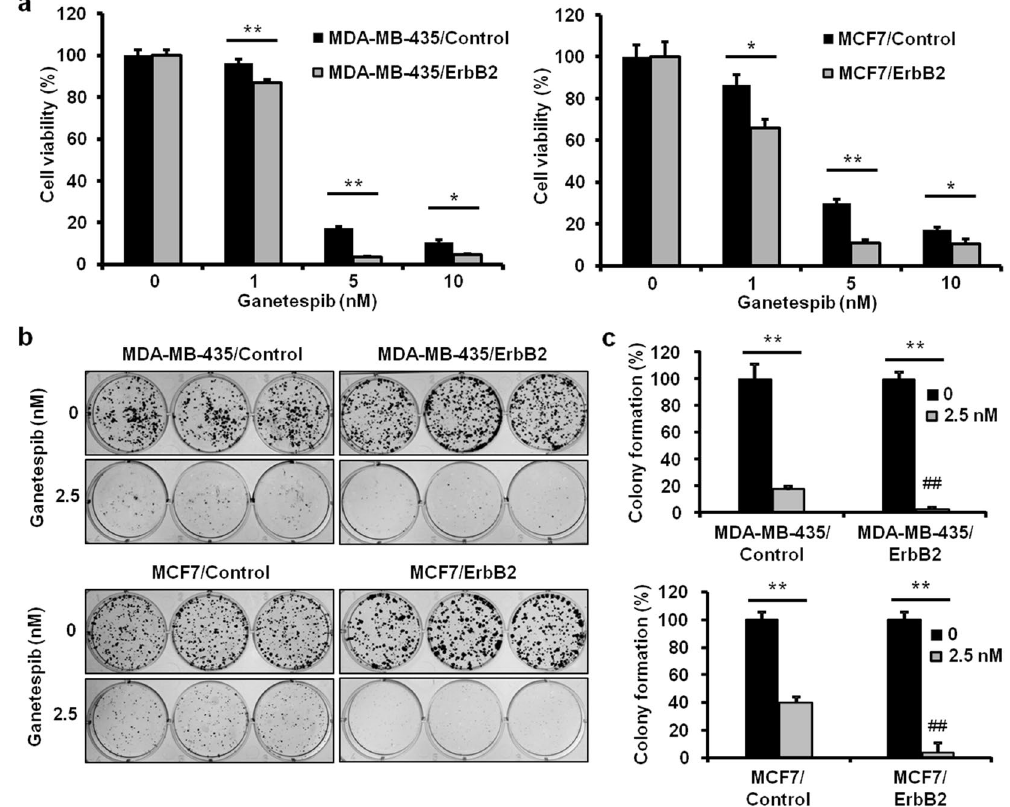
Figure 6. Ganetespib preferentially inhibits ErbB2 + cancer cells. ( a ) MDA-MB-435/Control, MDA-MB-435/ ErbB2, MCF7/Control, and MCF7/ErbB2 cells were treated with ganetespib (0, 1, 5, or 10 nM) and for 5 days, followed by an MTT assay to assess cell viability. The average percentages of viable cells relative to the untreated control cells in each cell line are graphed. For the clonogenic assay, these cells were treated with ganetespib (0 or 2.5 nM) for 14 days. Then, colonies were stained with crystal violet and quantified. Representative images of the crystal violet-stained colonies are shown in ( b ) with the corresponding graphs in ( c ). All values are presented as the means ± S.E. ( * P ≤ 0.05; ** P ≤ 0.01 as indicated; ## P ≤ 0.01 as compared to the ganetespib-treated parental Control cells).